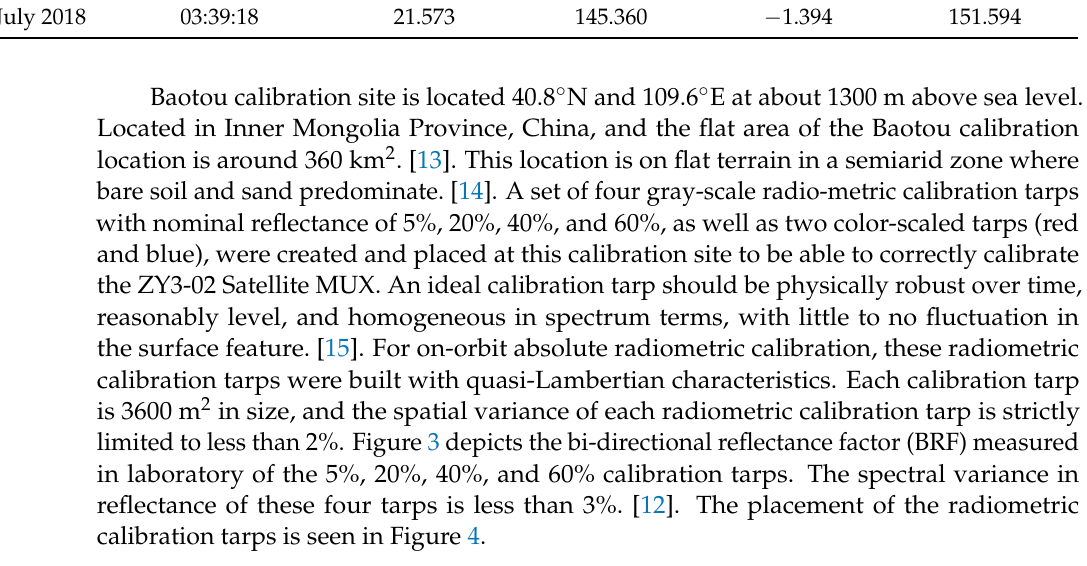
Figure 4. The spatial layout of the radiometric calibration tarps in this study at Baotou site. 2.4. Synchronous Reflectance and Atmospheric Parameters Measurements The four gray-scale and two color radiometric calibration tarps were 3600 m 2 , cover- ing about 10×10 pixels in the MUX image. Each single tarp in this study was divided into 5×5 samples, and 25 samples were collected within 10 min by spectroradiometer. The SVC HR-1024i spectroradiometer (spectral range of 350–2500 nm) collected the reflectance. Within 30 min of the satellite flyover time, the surface reflectance measurement was com- pleted. It is noteworthy that five spectra were collected in each sample of each single tarp; 750 spectra of the calibration tarps were collected in every calibration campaign. A CIMEL CE318 sun photometer was used to detect the total columnar water vapor (CWV) and aerosol optical depth (AOD) once every 3 min during the calibration cam- paign. Table 3 and Figure 5 show the measurement of AOD and CWV at Baotou site on June 28, 2018.